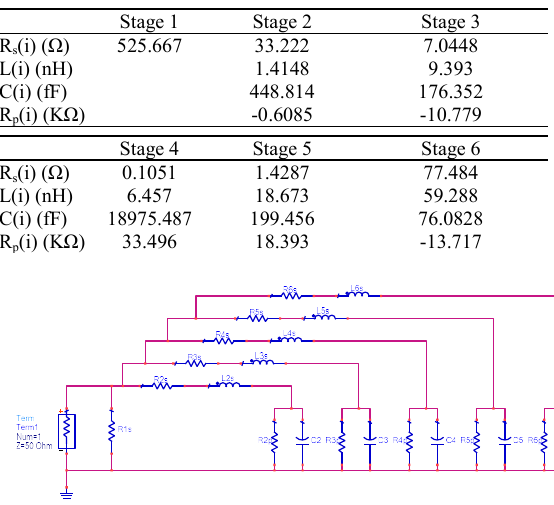
Figure 20: Spice circuit for patch antenna without CRR.